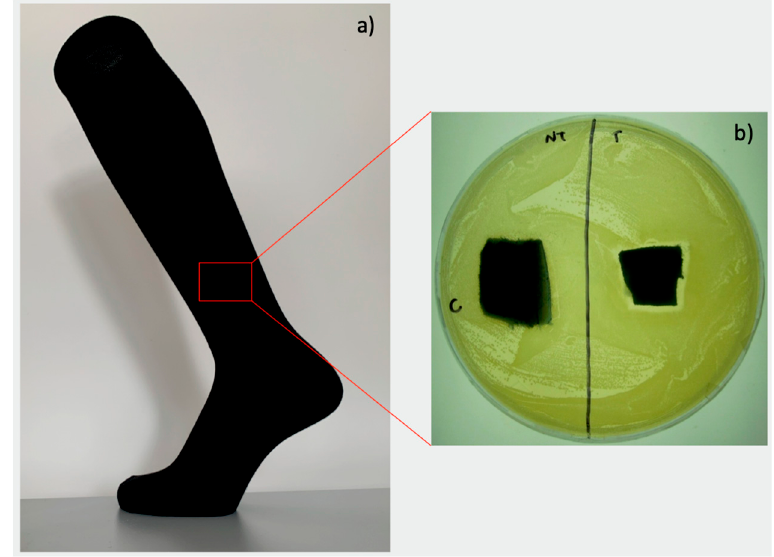
Figure 1. Silver treated device for prevention of infections in diabetic foot disease ( a ); Agar diffusion test demonstrating the good antibacterial properties of the device ( b ).